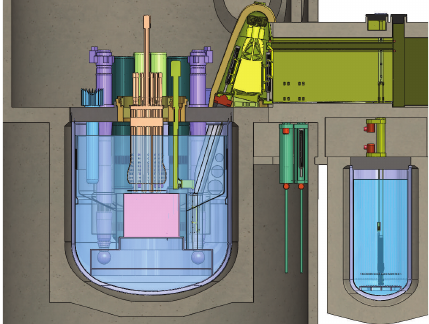
Figure 6: Vertical cross-section of the mixed way fuel handling route.